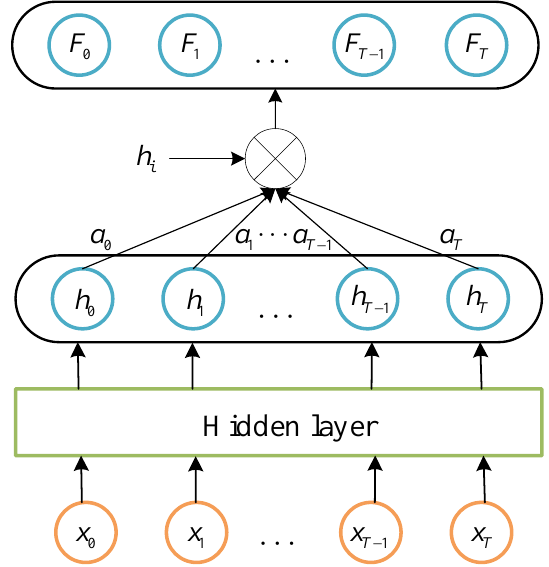
Figure 5. Schematic of the attention mechanism.